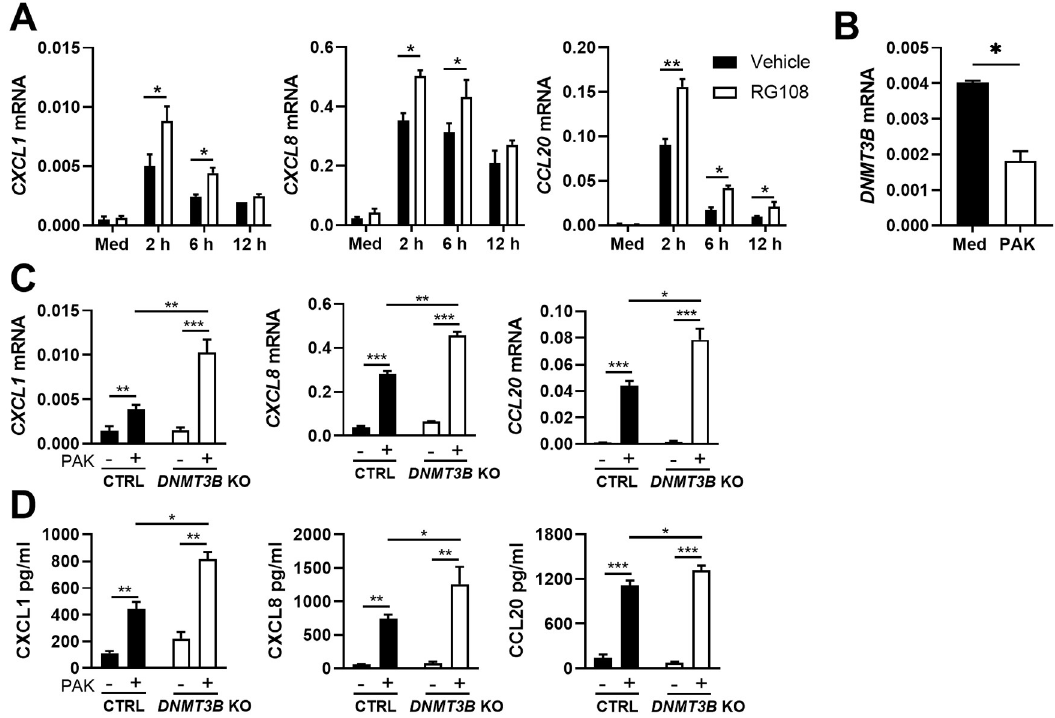
Fig 1. Dnmt3b inhibition in BEAS-2B bronchial epithelial cells promotes Pseudomonas aeruginosa induced chemokine production in vitro . BEAS-2B cells were pretreated with the DNMT inhibitor RG108 at 10 μ M/ml (open bars) or vehicle (black bars) for 12 hours and then stimulated with heat killed PAK (MOI = 50) or medium control for 2, 6 or 12 hours. CXCL1 , CXCL8 and CCL20 mRNA expression was measured by RT-qPCR (A); DNMT3B mRNA levels in BEAS-2B cells incubated with heat killed PAK or medium control for 12 hours (B); Dnmt3b deficient (knock out, DNMT3B KO; open bars) and control (Ctr; black bars) BEAS-2B cells were stimulated with heat killed PAK (+) or medium control (-) for 12 hours. CXCL1 , CXCL8 and CCL20 mRNA levels were measured by RT-qPCR (C) and corresponding protein levels in the supernatant by ELISA (D). Data are presented as means ± SEM (n = 4) and representative of two to three independent experiments and for two DNMT3B KO and control clones. � p < 0.05, �� p < 0.01, ��� p <